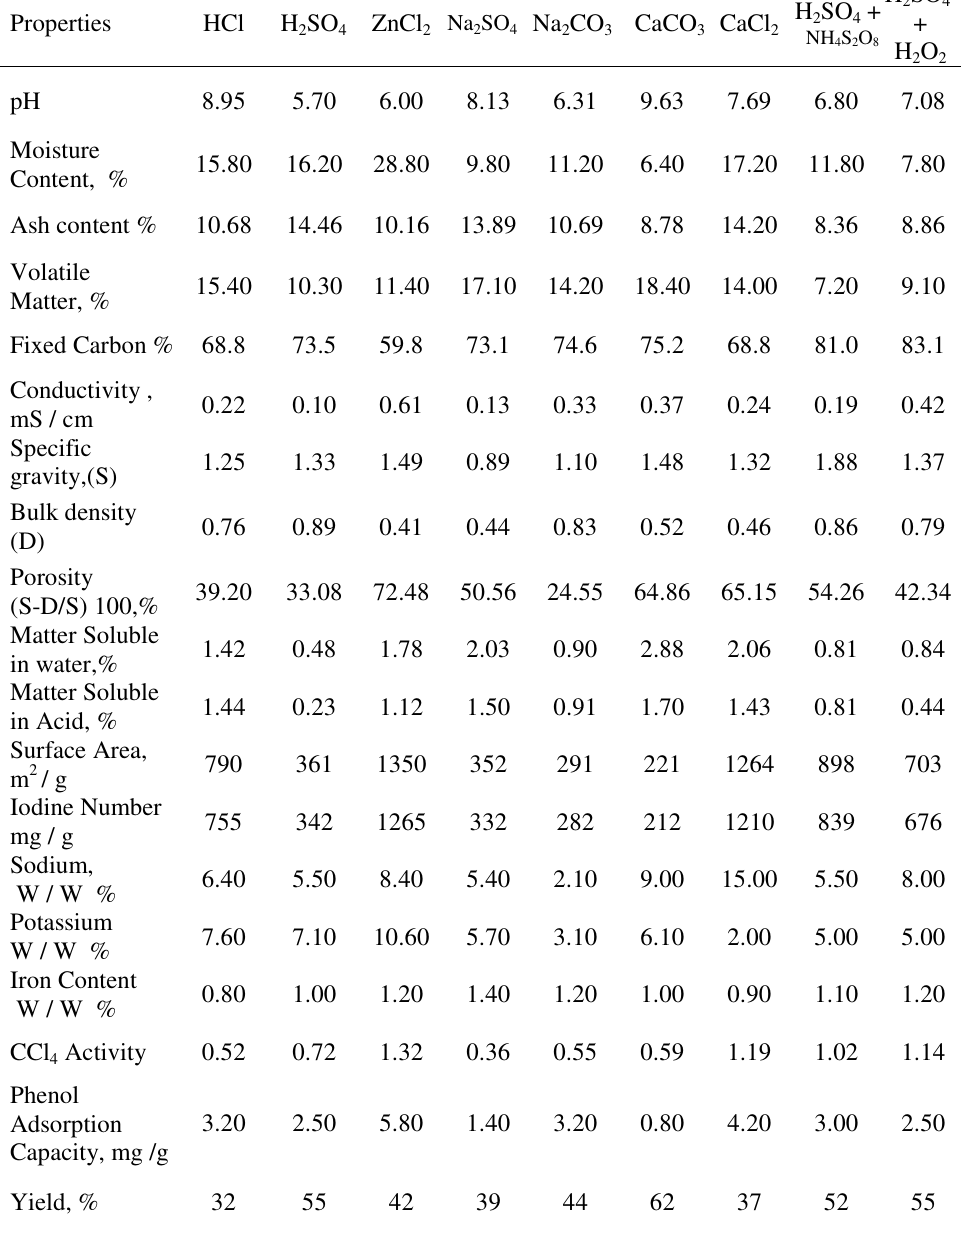
Table 1. Turmeric waste activated carbon